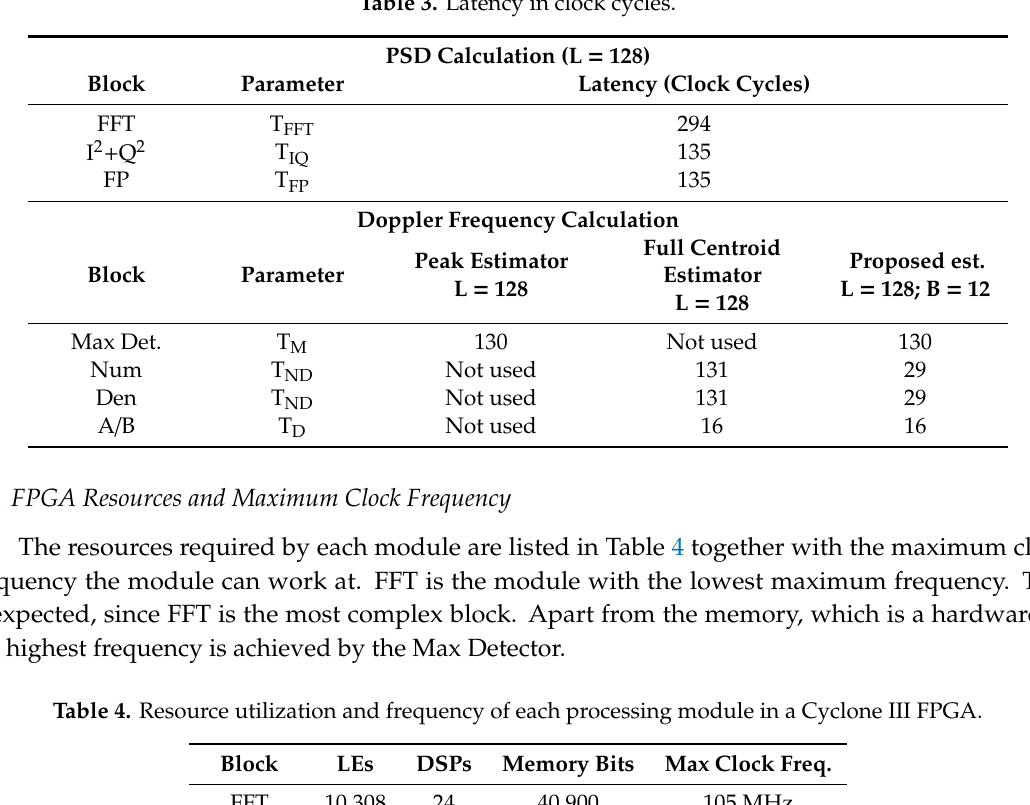
Table 3. Latency in clock cycles.